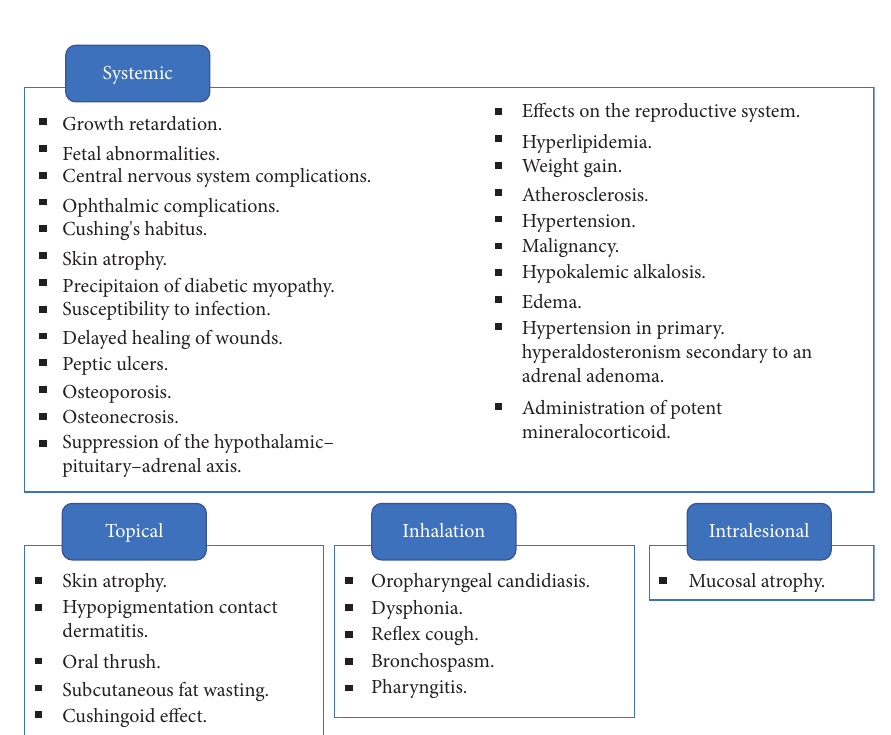
Figure 2: Side effects of cortisol according to the route of administration [12, 15–17]. Table 2: Equivalent doses of numerous corticosteroids.